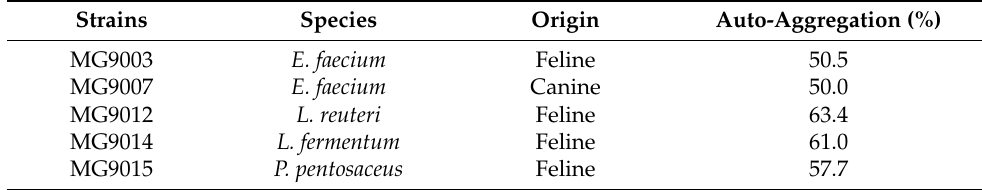
Table 2. The auto-aggregation of the selected strains.